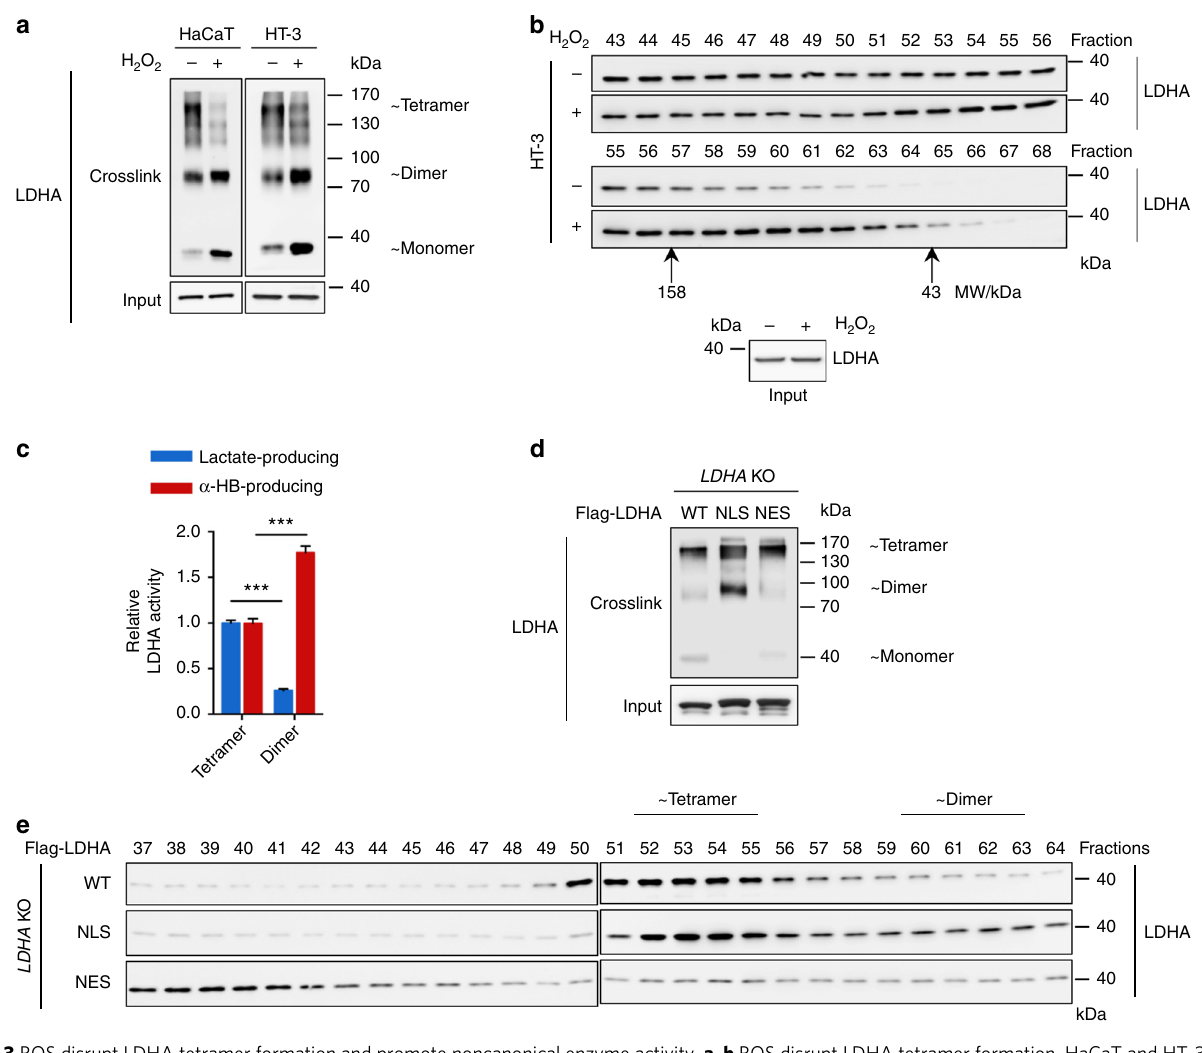
Fig. 3 ROS disrupt LDHA tetramer formation and promote noncanonical enzyme activity. a , b ROS disrupt LDHA tetramer formation. HaCaT and HT-3 cell extracts with or without 10 μ M H 2 O 2 treatment were crosslinked by 0.025 % glutaraldehyde and analyzed by western blotting using LDHA antibody. Tetrameric, dimeric, and monomeric LDHA were indicated ( a ). HT-3 cell extracts were prepared from 1 × 10 7 cells with or without 10 μ M H 2 O 2 treatment and passed over the gel fi ltration column. Fractions were collected every 0.25 ml per tube and analyzed by western blot for LDHA protein. Molecular mass, 158 and 43 kDa marked below the blots, were determined by Gel Filtration Calibration Kit HMW (GE Healthcare). The loading inputs for gel fi ltration were shown below ( b ). c Dimer LDHA presents the noncanonical enzyme activity. The canonical and noncanonical LDHA enzyme activity assays were measured on tetramer fractions (Fraction #56, #57) and dimer fractions (Fraction #60, #61) separated from gel fi ltration. d , e More dimers form in the LDHA NLS group compare with that of LDHA NES group. Cell extracts from HEK293T LDHA KO cells expressing Flag-tagged WT, NLS, and NES LDHA were crosslinked by 0.025 % glutaraldehyde and analyzed by western blotting using LDHA antibody. Tetrameric, dimeric, and monomeric LDHA were indicated ( d ). Cell extracts from HEK293T LDHA KO cells expressing Flag-tagged WT, NLS, and NES LDHA were passed over the gel fi ltration column. Fractions were collected every 0.25 ml per tube and analyzed by western blot for LDHA protein. Molecular mass was determined by Gel Filtration Calibration Kit HMW (GE Healthcare). Results are representative of three independent experiments. All data are shown as mean ± SEM. The p values were determined by two- tailed t -test. The values of p < 0.05 were considered statistically signi fi cant. *, **, and *** denote p < 0.05, p < 0.01, and p < 0.001, respectively. NS